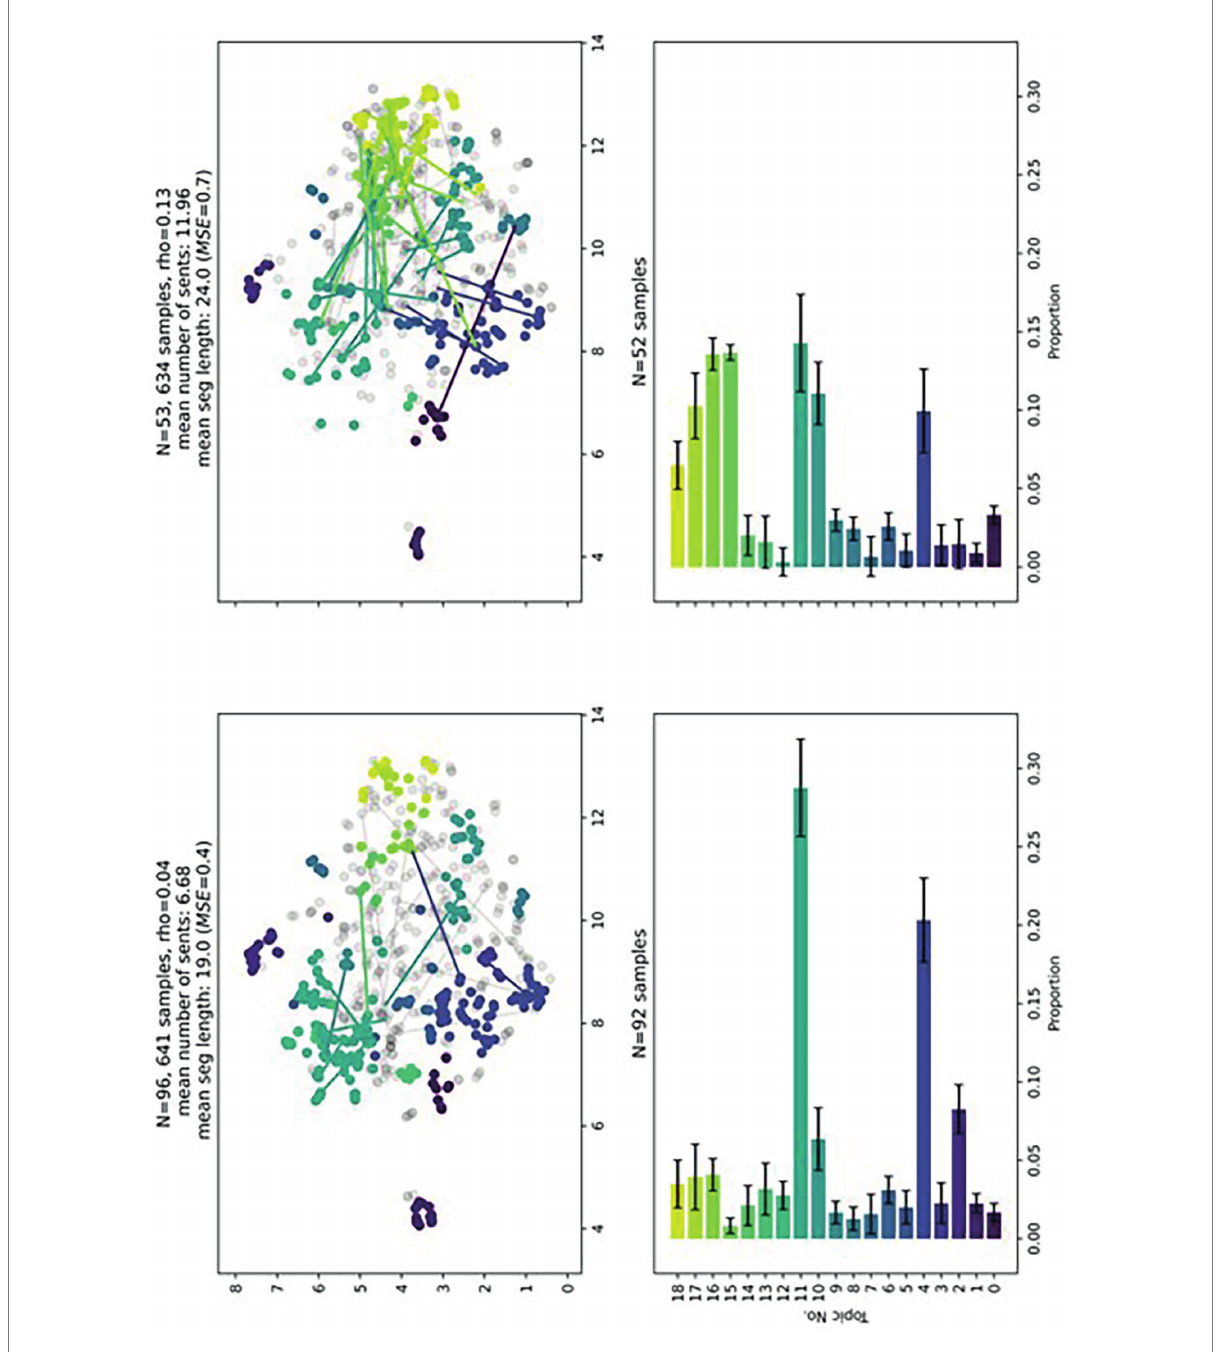
FIGURE 3 Representation space of the clusters and highlighted relationships between sentences (top row). Barplot for average proportions of topics in the evaluations for pre-service teachers with low (left) and high (right) text lengths. Color coding refers to the different